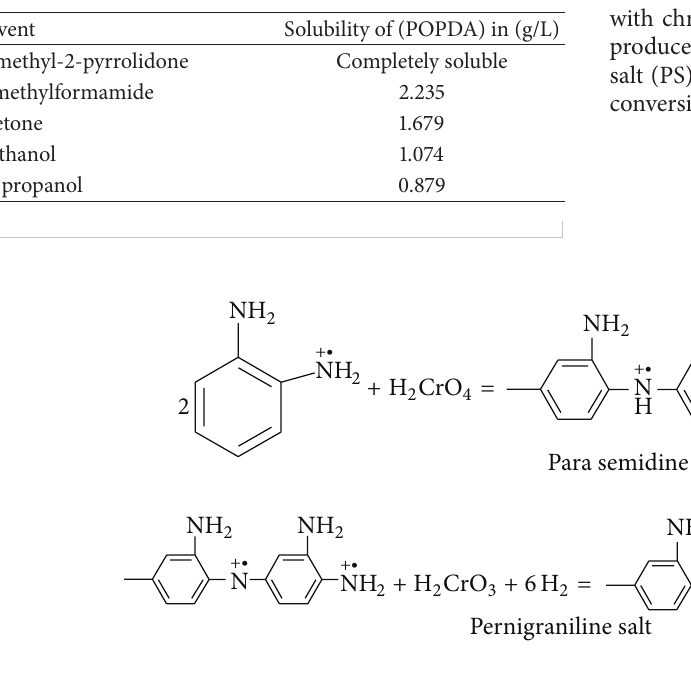
Table 1: Solubility of poly-o-phenylenediamine (POPDA) in differ- ent solvents at 20 ∘